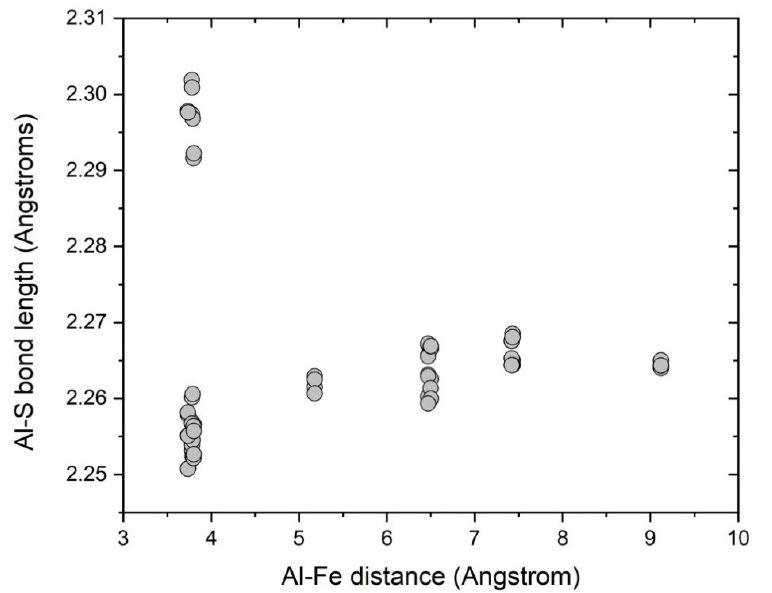
Figure A3. Al-S bond lengths plotted against Al-Fe separation for CuAlS 2 containing an isolated [ Fe ] 2 + antisite defect. Cu